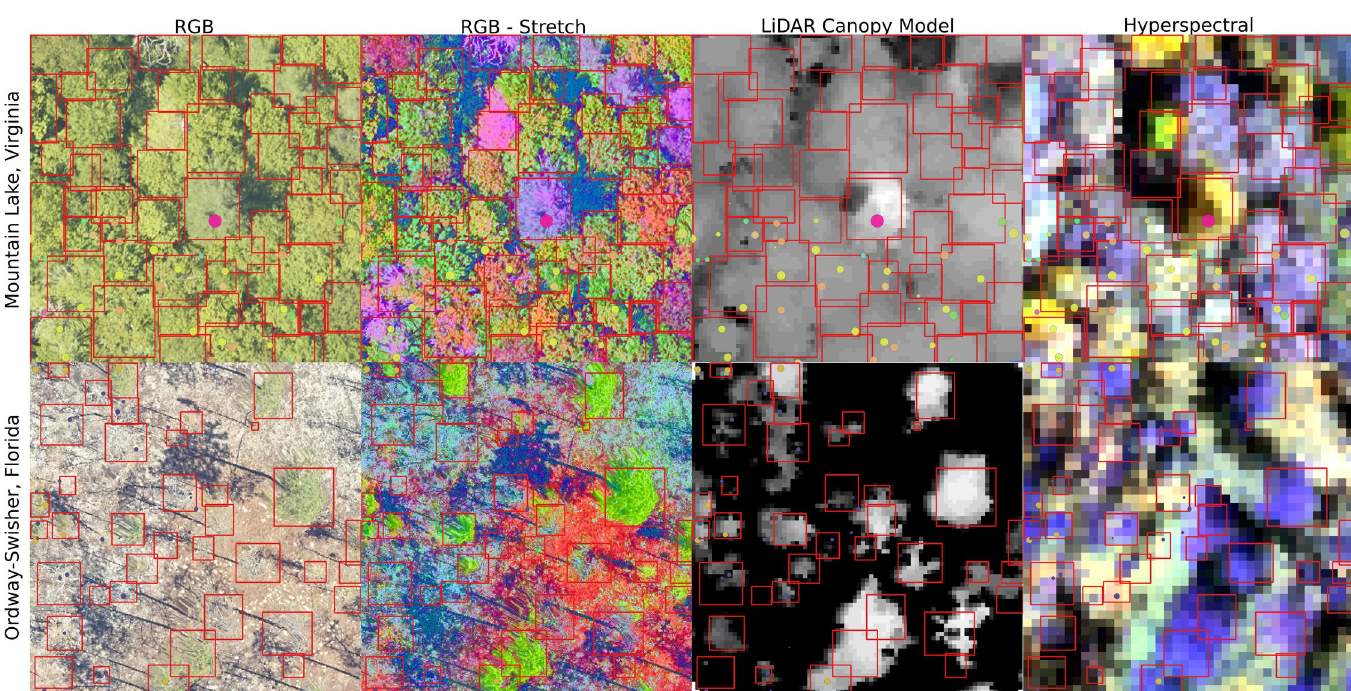
Fig 5. Image-annotated tree crowns for the evaluation data set for two sites in the National Ecological Observation Network. Using the RGB, LiDAR and hyperspectral products together contributes to more careful crown annotation. For some sites, such as MLBS (top row), the RGB and hyperspectral data are useful for differentiating overlapping crowns. For other sites, such as OSBS (bottom row) the LiDAR point cloud, shown as a rasterized height image, is most useful in capturing crown extent. The RGB-stretch image was produced by transforming the RGB data in the three principal components space. To create a three-band hyperspectral image, we used channels from the red, blue and infrared spectrum to capture changes in reflectance not apparent in the RGB